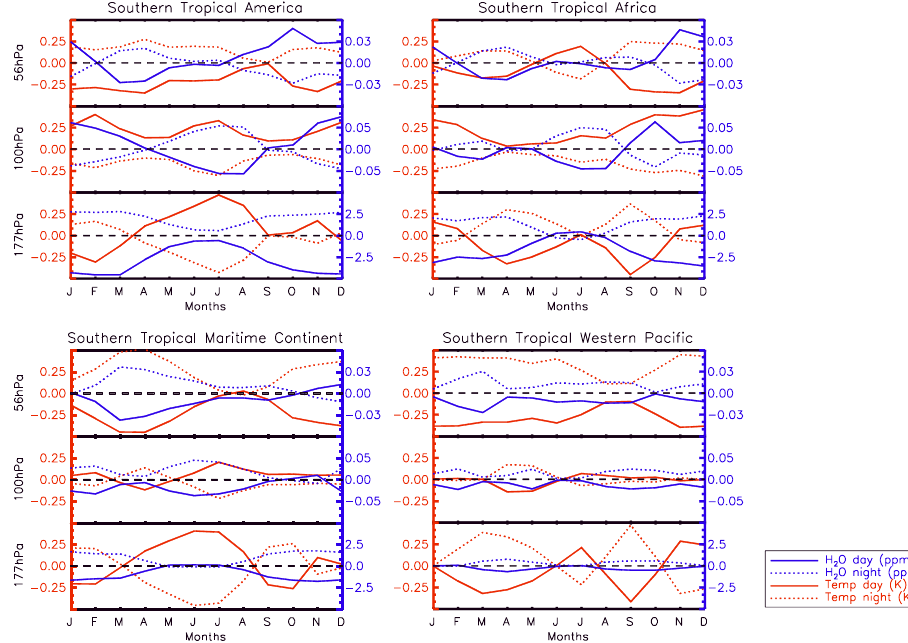
Figure 10. Monthly daytime H 2 O (blue solid line), night-time H 2 O (blue dotted line), daytime temperature (red solid line) and night-time temperature (red dotted line) anomalies, calculated for each month as the difference between the monthly average daytime (night-time) and the monthly average, for the 2005–2012 period, at 177, 100 and 56hPa in southern tropical America (top left) and southern tropical Africa (top right), the southern tropical maritime continent (bottom left) and southern tropical western Pacific (bottom